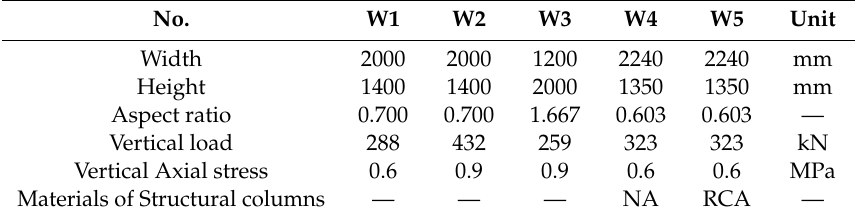
Table 3. Design of recycled concrete hollow block (RCHB) masonry